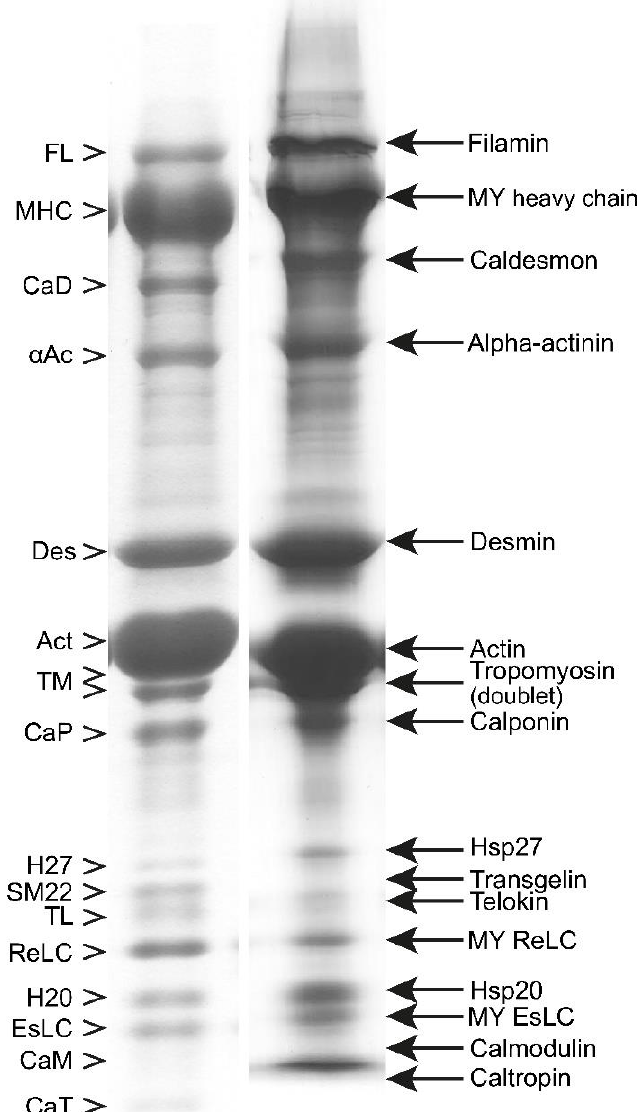
Figure 2. Identification of the major proteins of smooth muscle myofibrils by a gradient SDS PAGE. Left lane: turkey gizzard. Right lane: bovine trachea. The arrows on the right-hand side point to the individually labeled proteins. The empty arrowheads on the left-hand side point to the same proteins labeled with abbreviated names. In the right lane, calmodulin and caltropin overlap with the dye-front band.